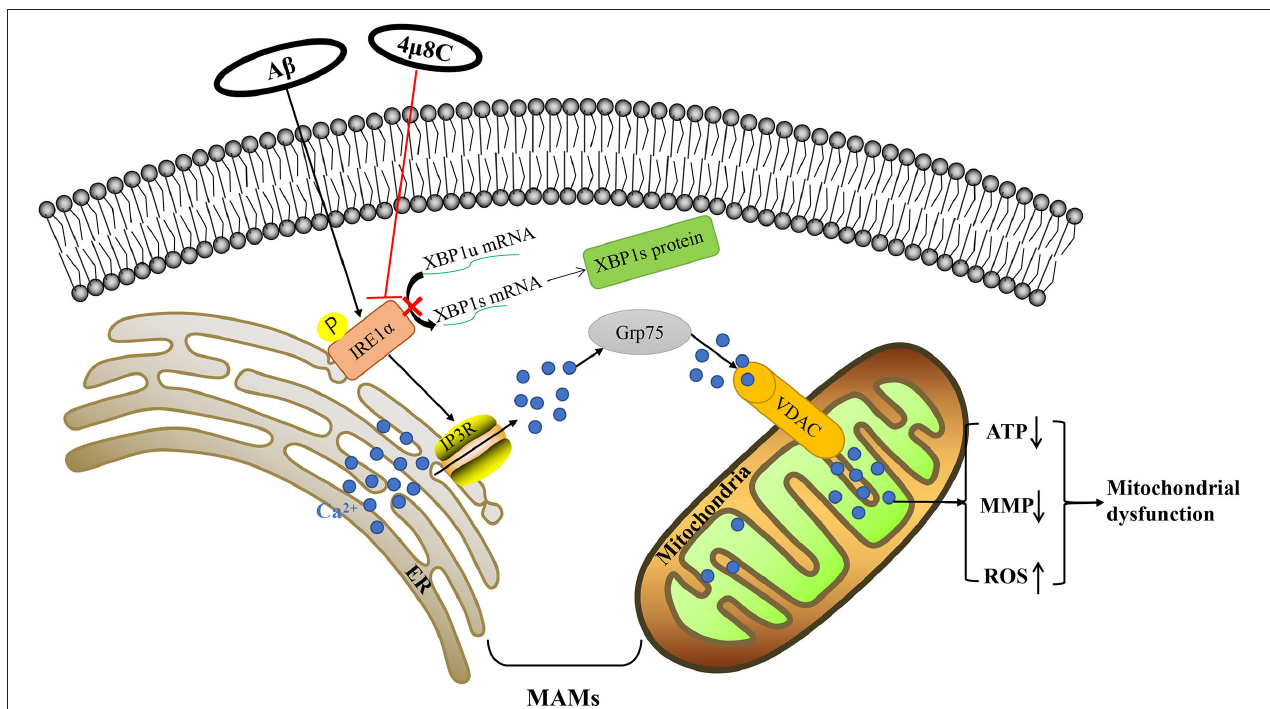
FIGURE 7 | Schematic diagram for A β -induced mitochondrial dysfunction via the IRE1 α -XBP1 pathway. Based on our experimental data, A β -induced activation of the IRE1 α -XBP1 pathway facilitated the expression and interaction of IP3R, Grp75, and VDAC1, which further led to the increased the level of ER–mitochondria association and malfunction of mitochondria-associated ER-membranes (MAMs). Then, the increase of calcium ions transferred from the ER to the mitochondria via MAM leads to mitochondrial dysfunction. Inhibition of the IRE1 α -XBP1 pathway ameliorated these A β 25–35-induced changes via the regulation of MAM, which fostered